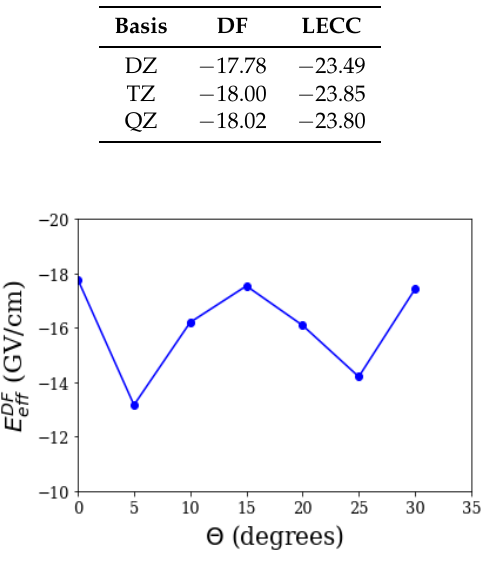
Figure 2. The Dirac–Focl (DF) effective electric field vs Θ